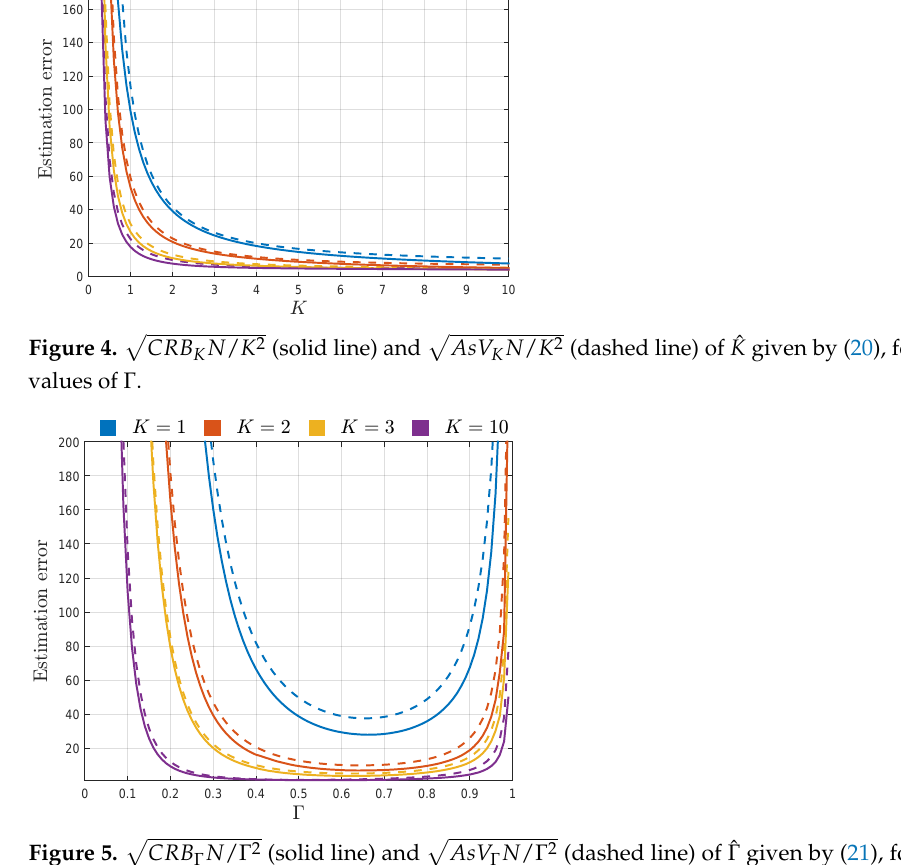
(cid:112) AsV Γ N / Γ 2 (dashed line) of ˆ Γ given by (21), for different